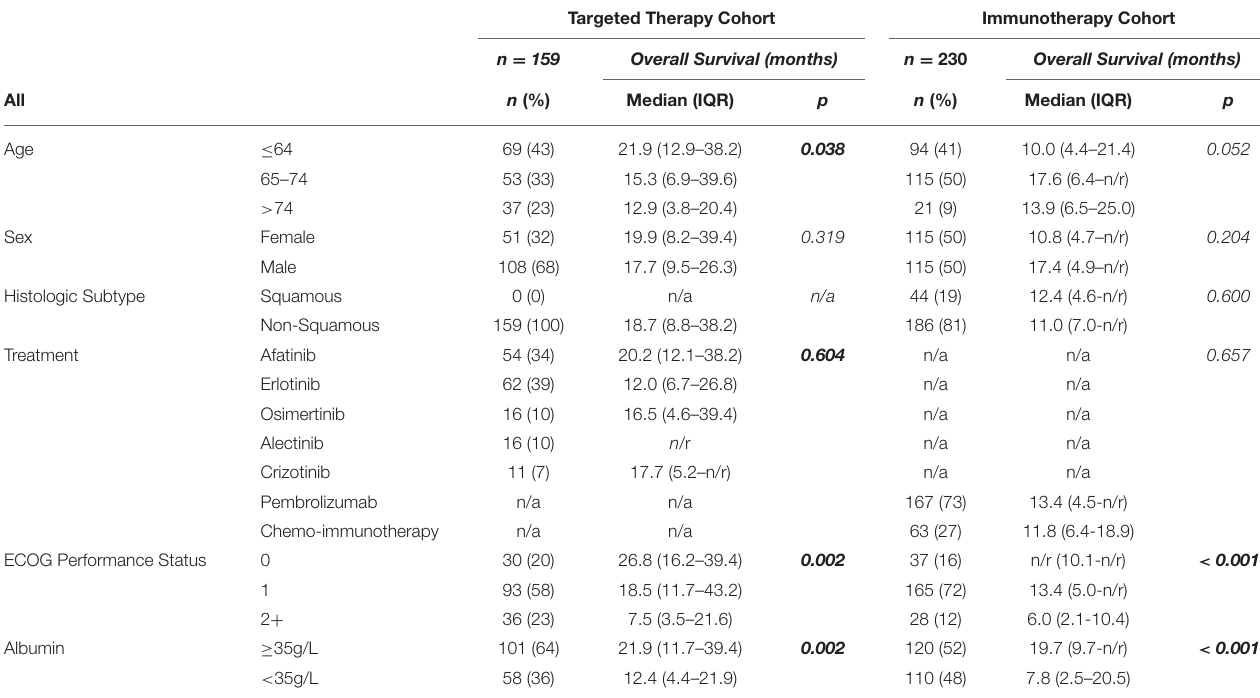
TABLE 1 | Clinical characteristics and survival in patients with NSCLC treated with first-line targeted therapy or immunotherapy-based therapy: univariate log-rank